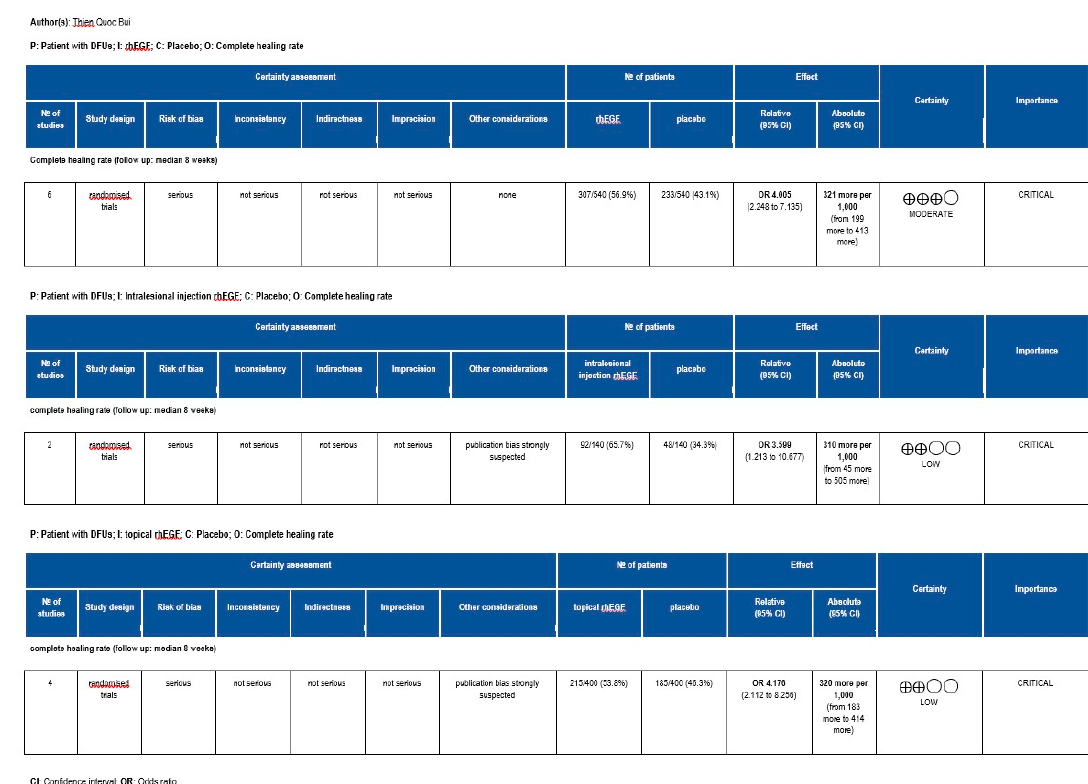
Figure A1. Grading of Recommendations Assessment, Development and Evaluation ( GRADE) evidence profile.